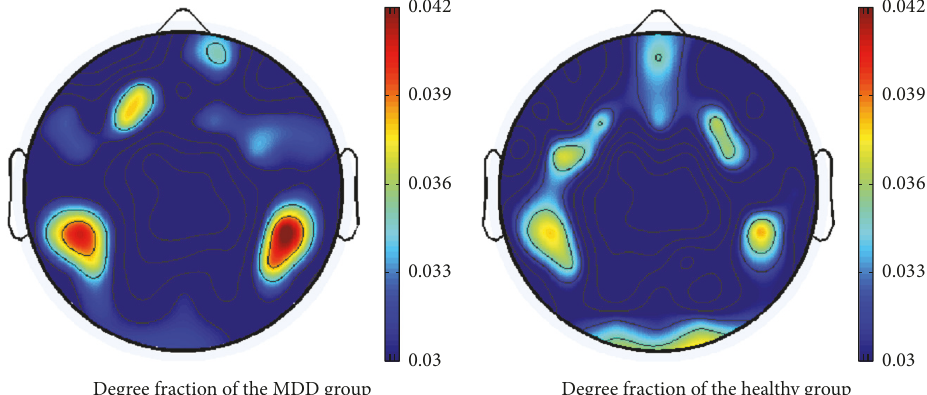
Figure 4: The brain topographic mappings of the degree fraction. The depth of the color represents the degree size of the nodes.